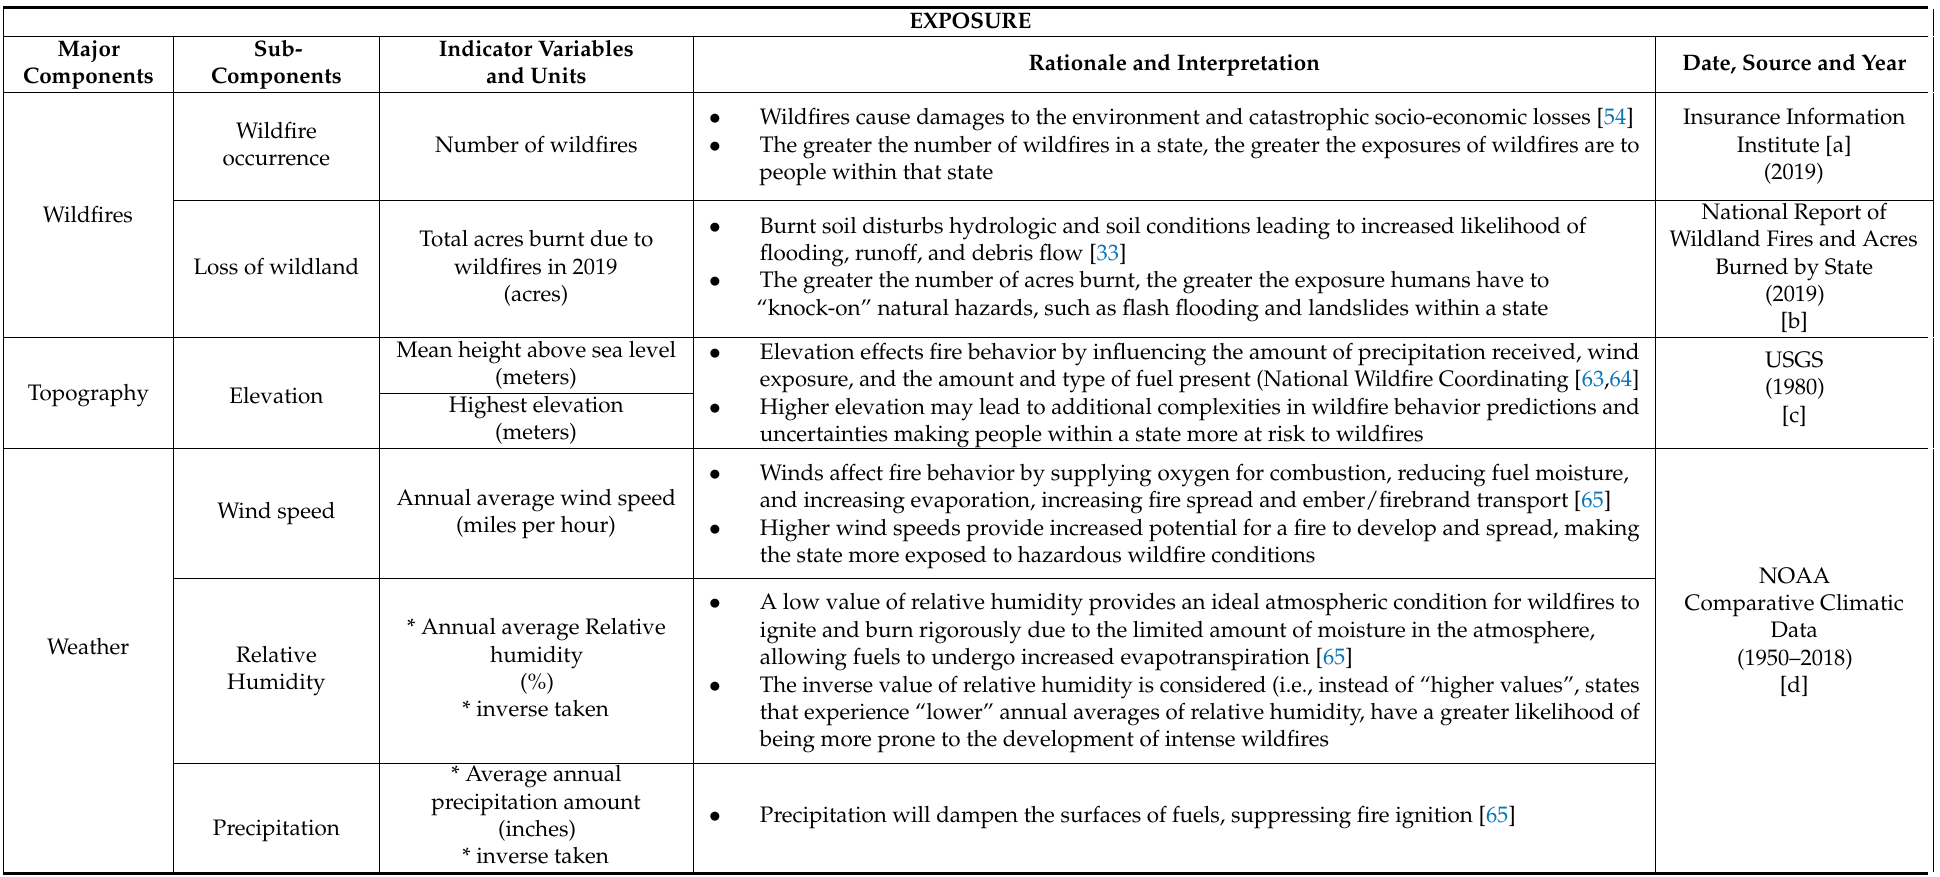
Table A2. LVI framework outlining the indicator variables, sub-components, and major components that feed into each contributing factor (exposure, adaptive capacity, and sensitivity). A rationale for each indicator is provided along with a description as to how the indicator is interpreted into the LVI framework. Asterisk (*) denotes indicator variables for which the inverse values were applied in the LVI equation. In addition, the data source and the year of analysis is